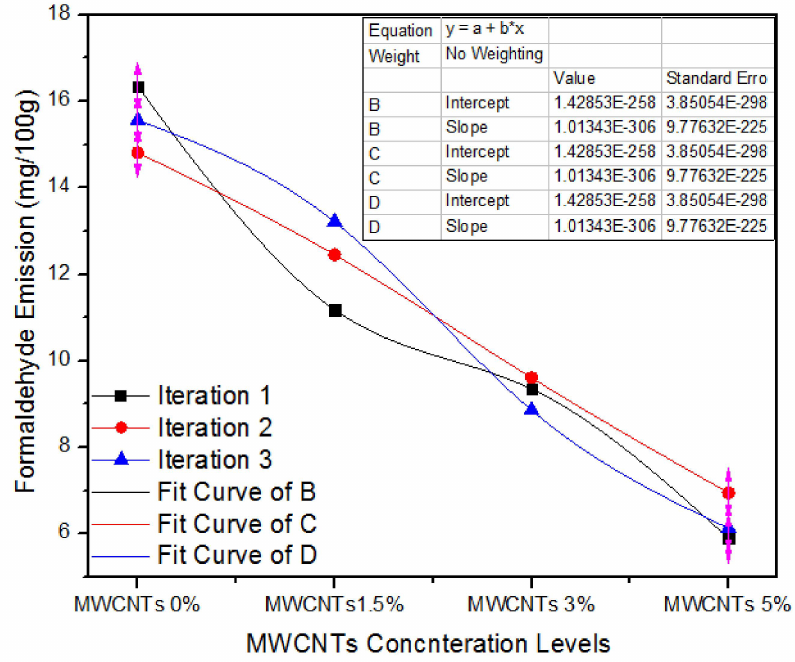
Figure 10. Numerical values of formaldehyde emission of numerous treatments of